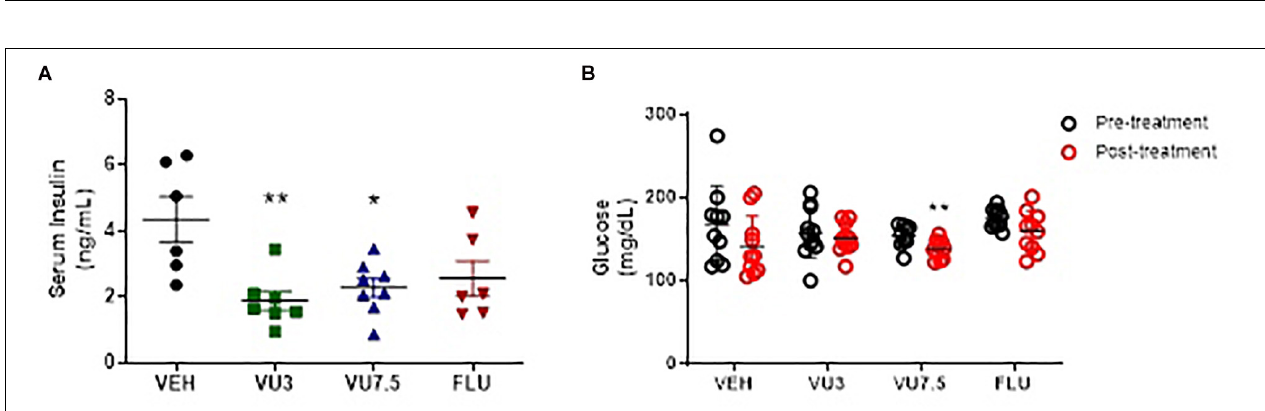
Frontiers in Neuroscience |